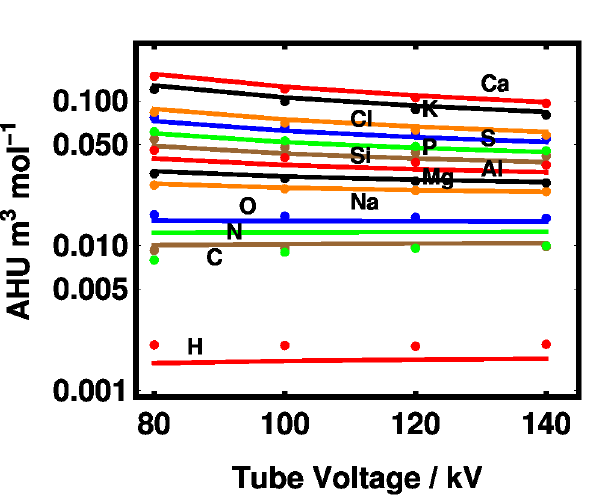
Fig 3. Theoretical prediction of AHU per mole density of a given element according to the XCOM cross sections of Fig 1 (lines) and the best-fit spectrum-detector model shown in Fig 2 (points). The curves represent the 13 elements used in the experiment (H, C, N, O, Na, Mg, Al, Si, P, S, Cl, K, and Ca).